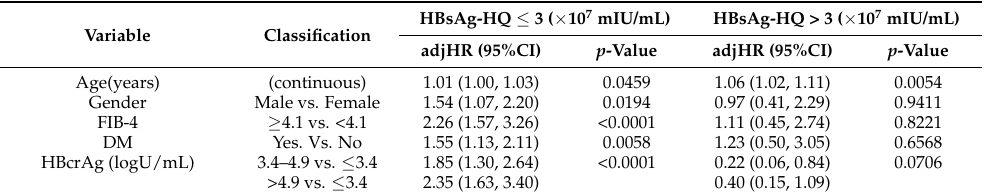
Table 4. Multivariable analysis for risk factors associated with the development of hepatocellular carcinoma in patients by HBsAgHQ level